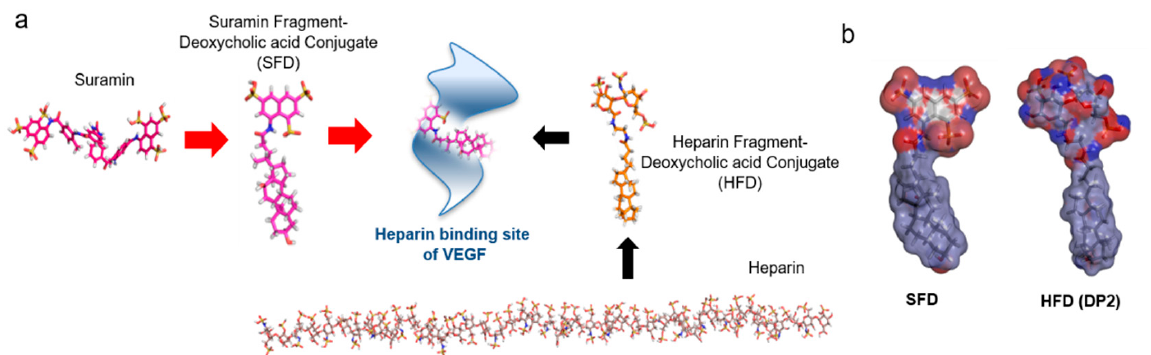
Figure 1. ( a ) Schematic rational design of a suramin fragment and deoxycholic acid conjugate (SFD) representing binding to the heparin-binding site of vascular epithelial growth factor (VEGF) compared to a heparin fragment deoxycholic acid conjugate (HFD). ( b ) The surface charge of the SFD and HFD show similarities in molecular binding.